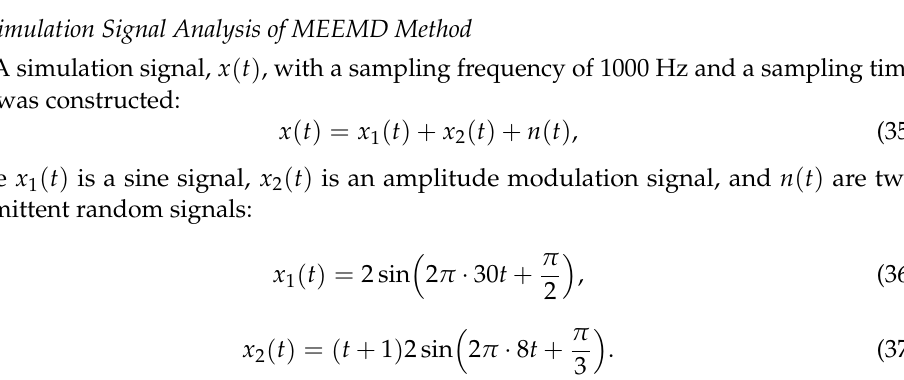
Figure 5. Some pictures of the fault elements: ( a ) Single slipper wear fault; and ( b ) Center spring worn